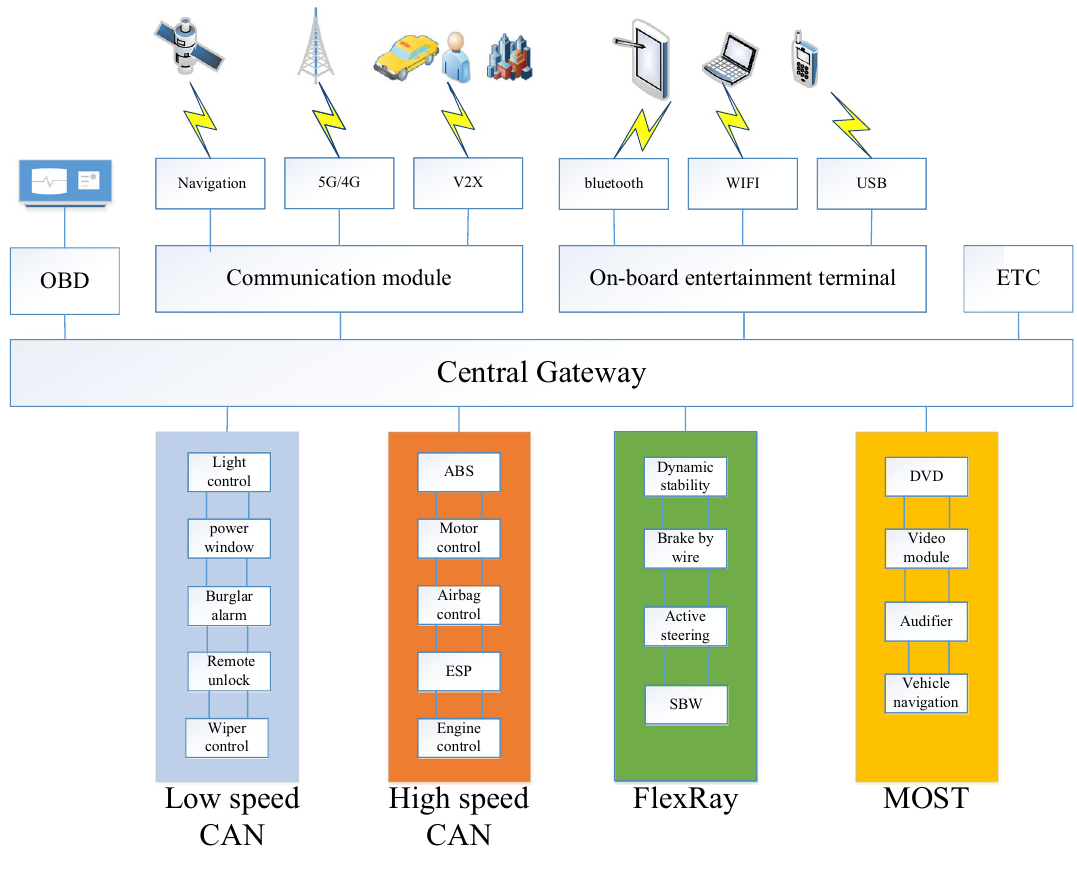
Figure 2. Internet of vehicles network topology.